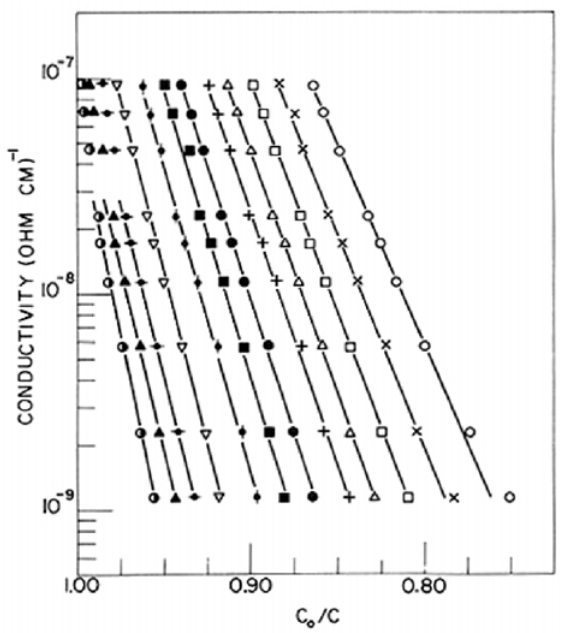
FIGURE 2b Conductivity profiles across oxide film of anodized niobium heated in air at 170 (cid:4) for 30min. s , 23.8 (cid:4) ; (cid:5) (cid:3) , 12.0 (cid:4) ; u , 2.4 (cid:4) ; D , (cid:1) 7.0 (cid:4) ; þ , (cid:1) 15.0 (cid:4) ; , (cid:1) 26.0 (cid:4) ; j , (cid:1) 35.0 (cid:4) ; vertical dash with center dot, (cid:1) 71.0 (cid:4) ; black D , (cid:1) 80.0 (cid:4) ; half dark circle, (cid:1) 90 (cid:4)